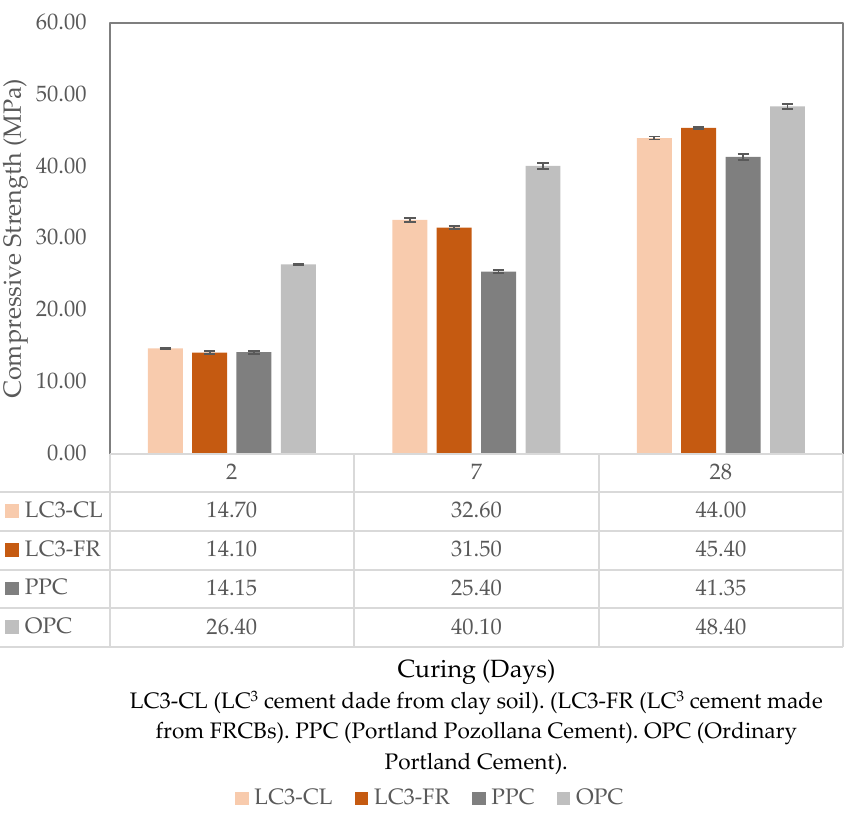
Figure 1. Compressive strength results for LC 3 blends, PPC, and OPC. As expected, the compressive strength increased with the curing period for all cement categories. This is attributed to the process of cement hydration of the main cement phases, such as C 3 S (Ca 3 SiO 5 ), C 2 S (Ca 2 SiO 4 ), C 3 A (Ca 3 Al 2 O 6 ), and C 4 AF (Ca 4 Al n Fe 2-n O 7 ), which leads to progressive strength gain with curing time [19]. Hydration of C 3 S and C 2 S are the main phases responsible for strength development. The reaction of these main phases with water (H 2 O) can be represented by Equations (2) and (3) [20,21].